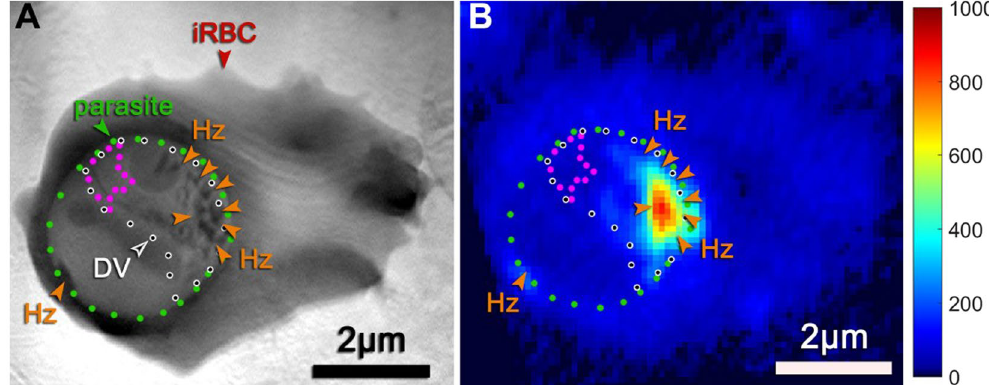
Figure 4. Infected red blood cell (parasite 8 in Table 1) imaged by soft X-ray tomography and scanning iron X-ray fluorescence and subject to alignment by 3D segmentation and fluorescent modeling as described in the Results and Methods. ( A ) Soft X-ray tomography projection image of the infected cell. The dotted lines delineate the parasite (green), its digestive vacuole (black-on-white), and the area of the digestive vacuole free from hemozoin fluorescence signal (magenta). Some of the hemozoin crystals are indicated by orange arrows. ( B ) Iron x-ray fluorescence map of the same cell aligned to its x-ray tomography dataset.